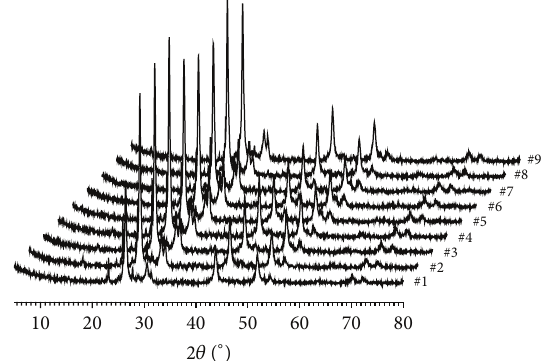
Figure 3: Powder XRD spectrum of nine Zuotai samples. Note: #1 is the sample of Aba Prefecture Tibetan Medicine Hospital; #2 is the sample of Gan’na Prefecture Tibetan Medicine Hospital; #3, #4, and #5 are the samples of the Company of Tibetan Medicine of Tibetan Traditional Medical College; #6, #7, and #8 are the samples of Qinghai Province Tibetan Medicine Hospital; #9 is the sample of the Company of Tibetan Medicine of Tibetan Autonomous